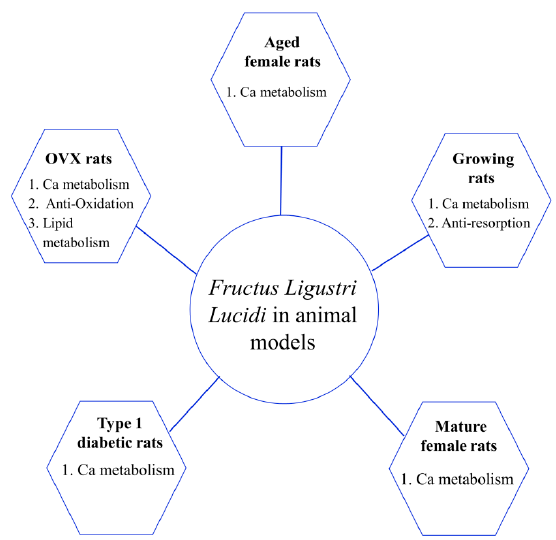
Figure 3. Fructus Ligustri Lucidi exhibited beneficial effects on bone metabolism in different animal models through improving Ca metabolism, reducing oxidative stress, regulating lipid metabolism and inhibiting bone resorption. Notes: Ca, calcium; OVX, ovariectomized .